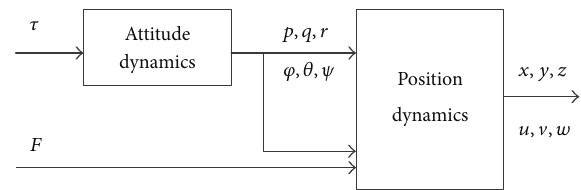
Figure 4: Simplified block diagram of the quadrotor’s dynamics.